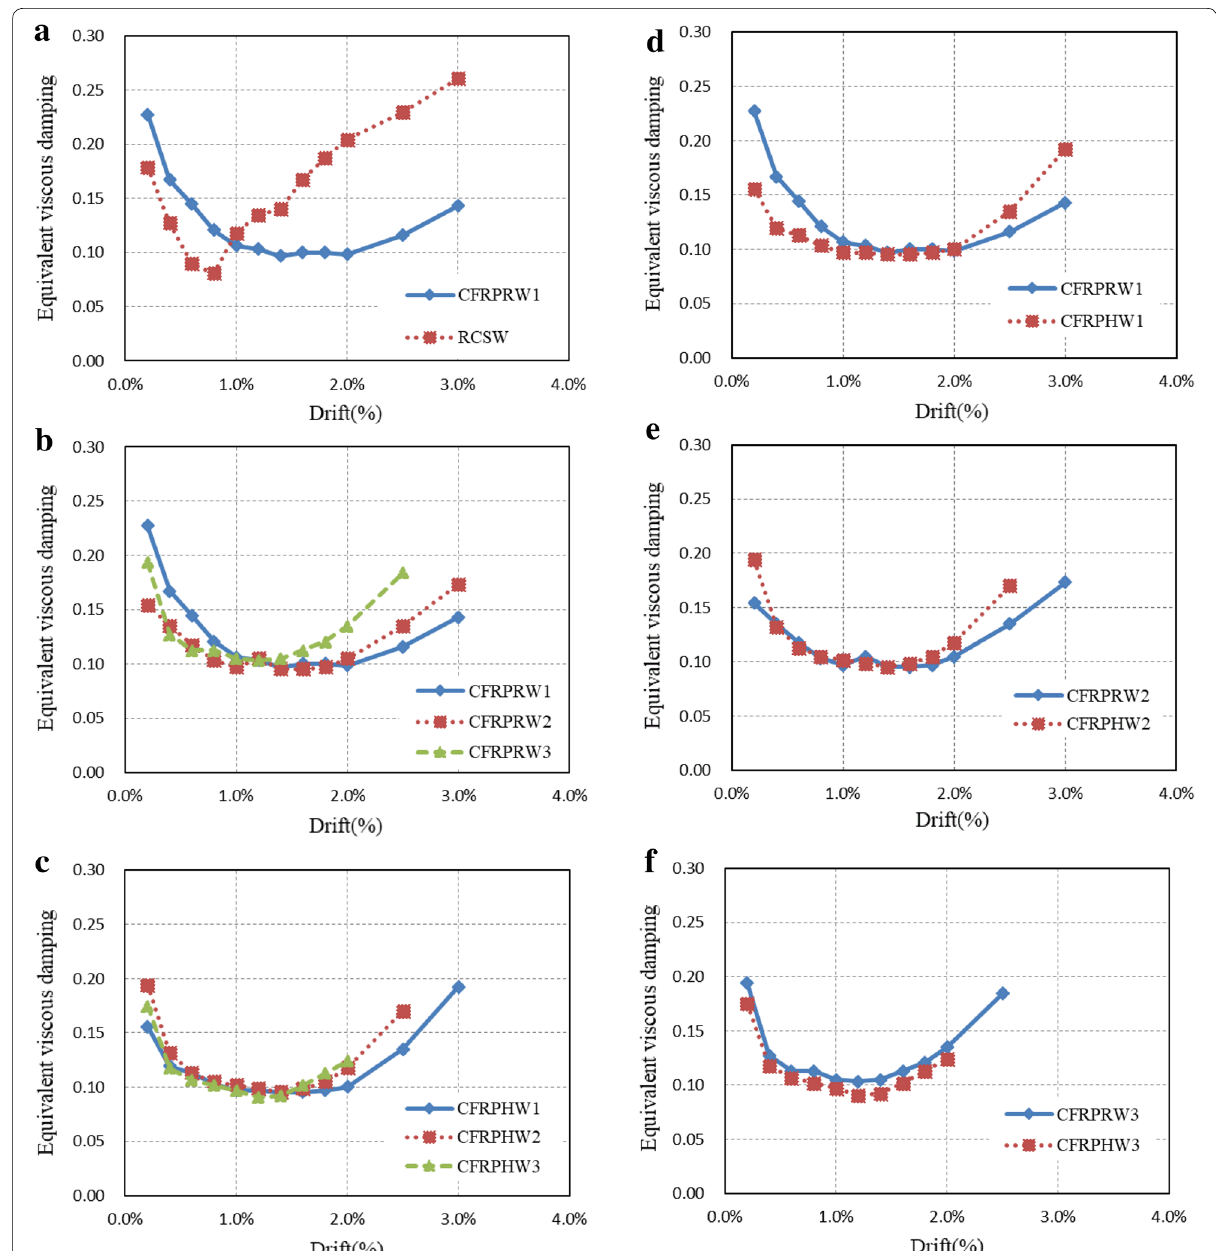
Fig. 10 Equivalent viscous damping coefficient ( a comparison between ordinary and CFRP walls. b Specimens with rectangular stirrups at different axial compression ratios. c Specimens with circular stirrups at different axial compression ratios. d Specimens at 0.17 axial compression ratio. e Specimens at 0.26 axial compression ratio f Specimens at 0.33 axial compression ratio).